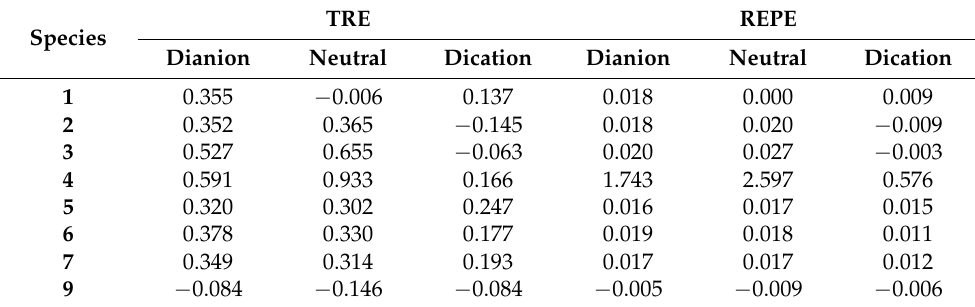
Table 1. TREs and REPEs for quasicirculenes 1 − 7 , 9 and their double charged ions. TRE REPE Species Dianion Neutral Dication Dianion